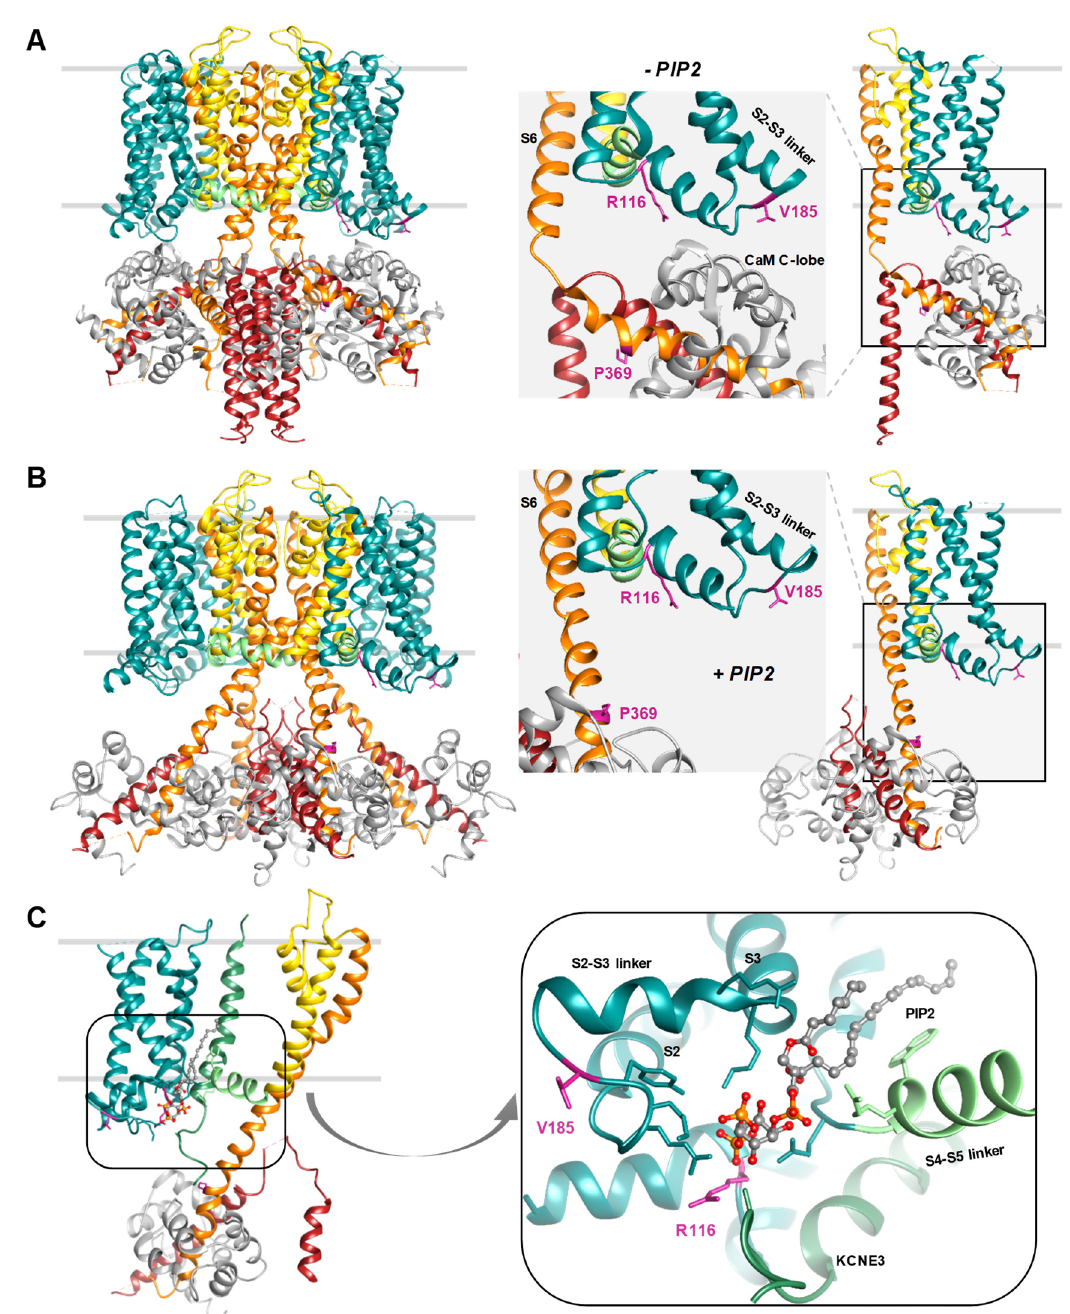
Figure A2. Structure models of the KCNQ1-CaM complex in the PIP2-free and the PIP2-bound state and location of amino acid residues R116, V185 and P369. ( A , B ) Visualization of KCNQ1 (transmembrane helices S1 to S4 in turquoise, S4–S5 linker in light green, S5 in yellow, S6 and helix A in orange and helices B and C in red) and CaM (in grey) in the tetrameric KCNQ1-KCNE3-CaM complex in the PIP2-free state ( A , based on pdb 6V00) and in the PIP2-bound state (B), based on pdb 6V01) and orientation in the membrane (gray lines). KCNE3 has been removed for clarity. Amino acid residues R116, V185 and P369 are highlighted in magenta and shown as sticks in a single KCNQ1 subunit. On the left, KCNQ1 and CaM are shown as a tetrameric channel complex. On the right, one KCNQ1 subunit with the highlighted amino acid residues R116, V185, and P369 and one CaM subunit are shown. The structural rearrangement of S6 and helix A, which form two helices connected by a loop in the PIP2-free state ( A , right panel) to a continuous straight helix in the PIP2-bound state, is shown ( B , right panel). The insets in the middle show a magnification to highlight the location